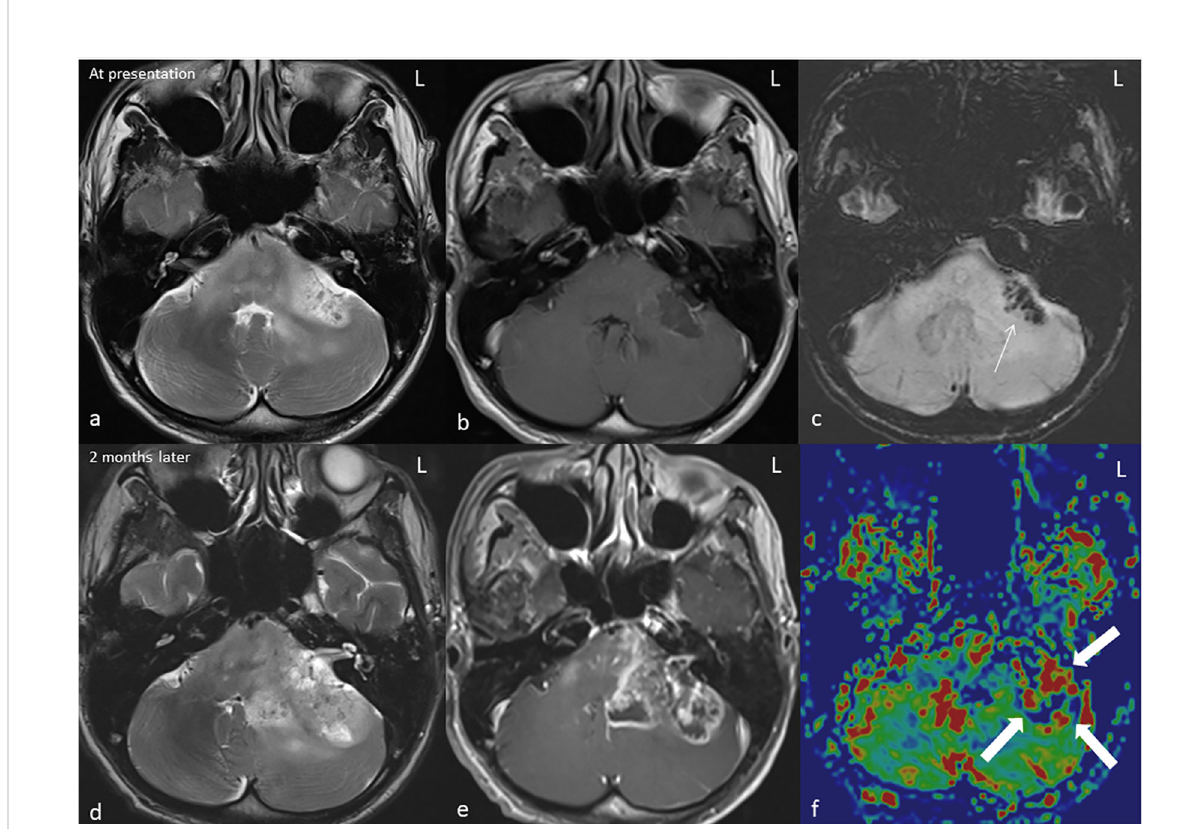
FIGURE 2 MRI* of the brain in axial T2W** (A, D) , T1W*** post gadolinium (B, E) , SWI**** (C) , and rCBV***** colour map (F) at presentation (top row) and at 2 months (bottom row). The left middle cerebellar peduncle mass demonstrates a heterogeneous hyperintense signal on T2 with minimal peripheral enhancement on T1 post-contrast. The hypointensity on SWI*** indicates presence of hemosiderin (arrow). The lesion signi fi cantly increases in size on the follow-up MRI ( C, D ) causing signi fi cant mass effect; the enhancement is more heterogeneous with irregular rim enhancement and central necrosis. Increase in rCBV at the enhancing region of the rCBV colour map indicates a high-grade tumour (block arrow). *Magnetic resonance imaging, **T2- weighted, ***T2-weighted, ****susceptibility-weighted imaging, and *****relative cerebral blood